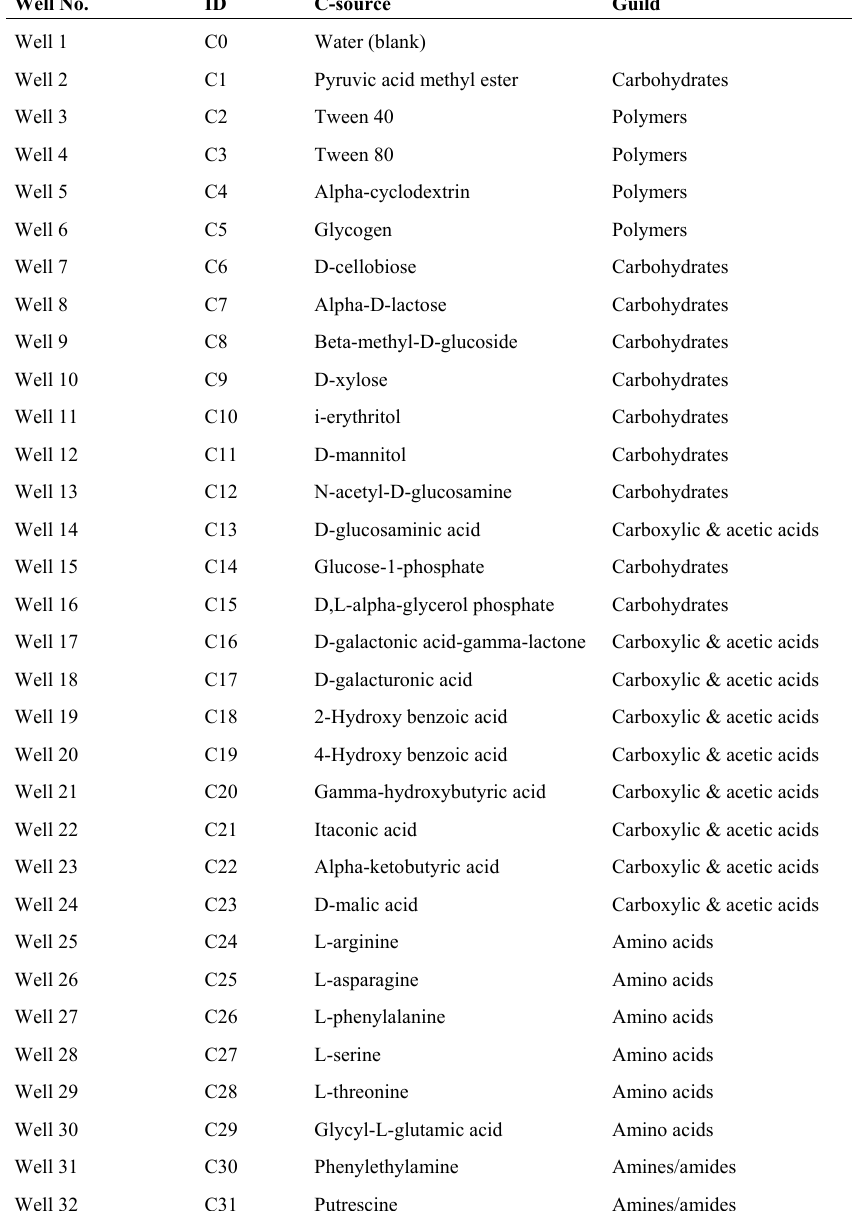
Table 3. Biolog Ecoplate TM carbon source guild groupings [37]. Well